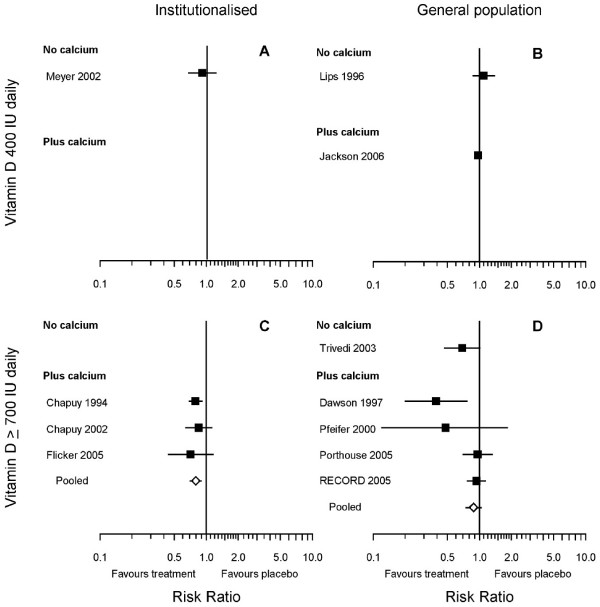
Risk ratios for any nonvertebral fracture according to target population, vitamin D dose and concurrent use of calcium. Bars represent 95 percent confidence intervals.